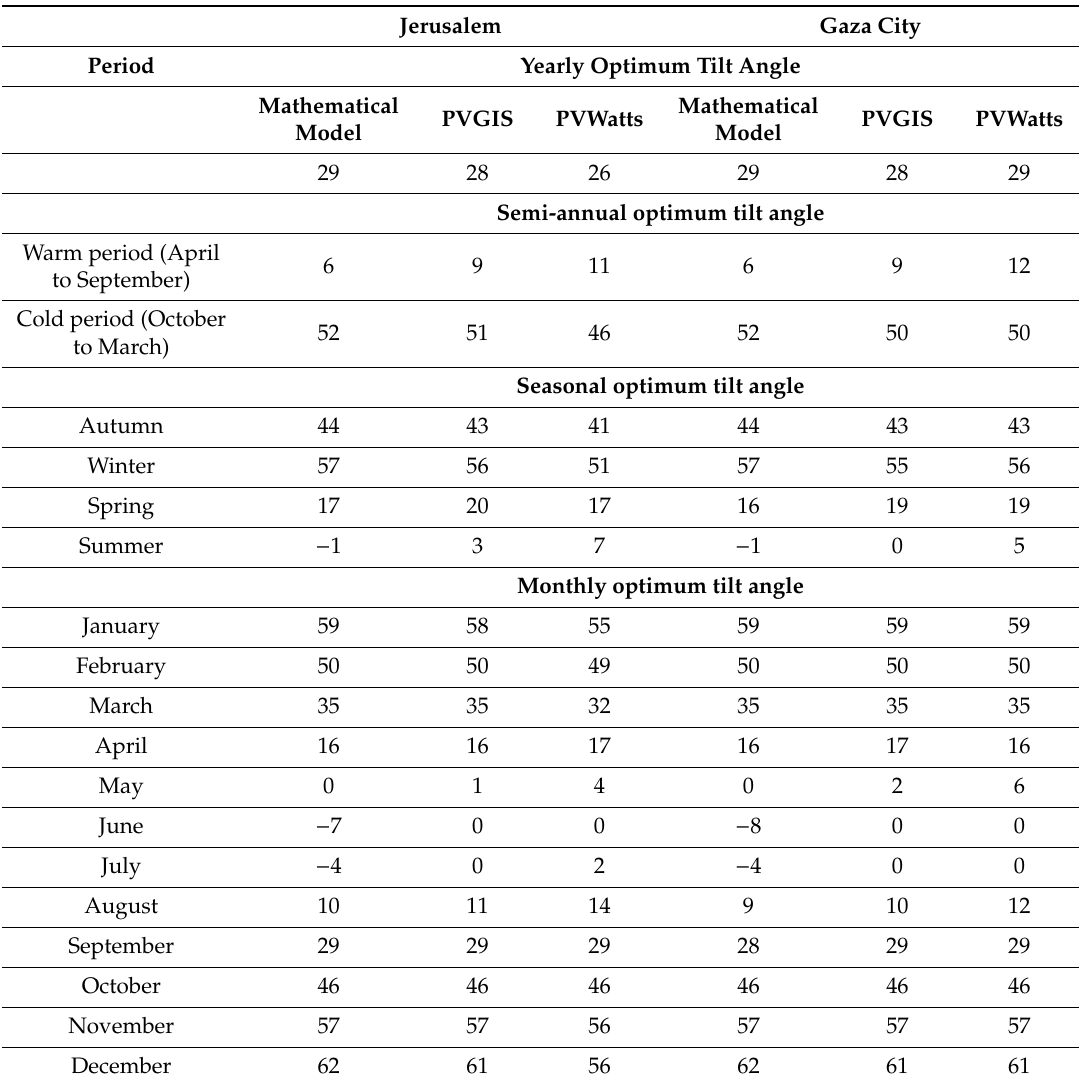
Table 14. A comparison of monthly, seasonal, semi-annual, and yearly optimum tilt angles (degrees) for Jerusalem and Gaza City based on PVWatts and PVGIS with those calculated in the present